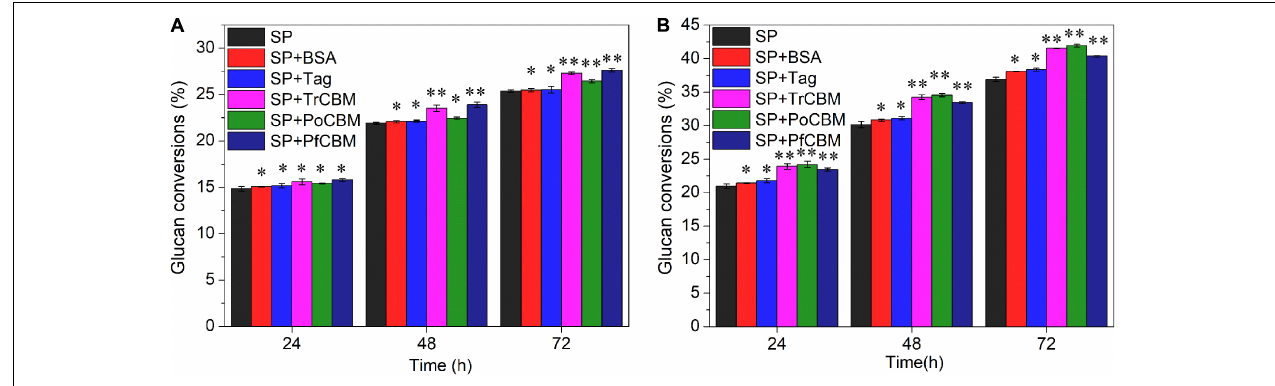
FIGURE 2 | Effect of the addition of BSA, Tag, TrCBM, PoCBM, and PfCBM proteins (1.5 mg/g DM) on glucan conversions of FP (A) and LPCS (B) at 72 h of enzymatic hydrolysis. ∗∗ Represents that there was a significant difference ( p < 0.05), and ∗ means that the difference was not significant ( p > 0.05).